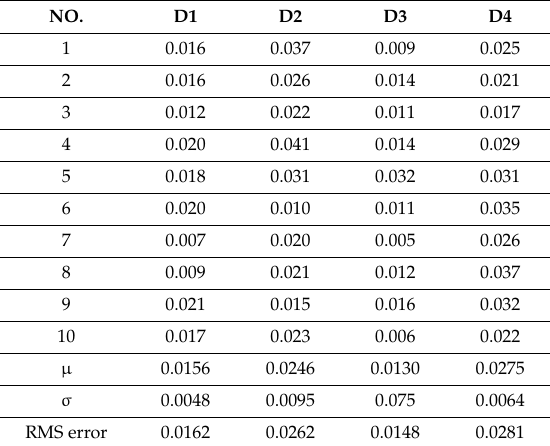
Table 7. Statistical results (unit: